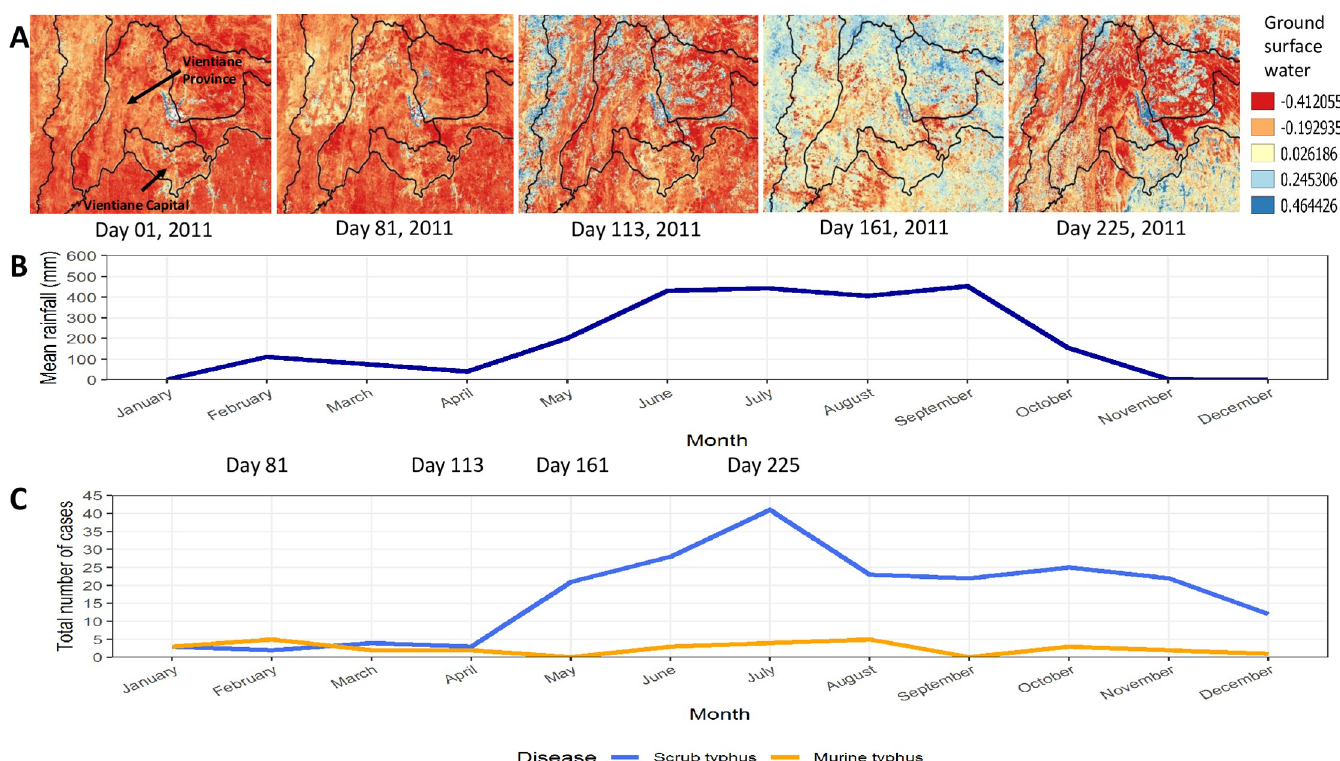
Fig 6. Year 2011. A. Amount of surface water for Vientiane Capital and Vientiane Province B. Combined mean rainfall per month for Vientiane Capital and Vientiane Province C. Number of patients with scrub typhus and murine typhus from Vientiane Capital and Vientiane Province per month. Maps were created using QGIS version 3.4.9. All layers were created by the authors of this manuscript.